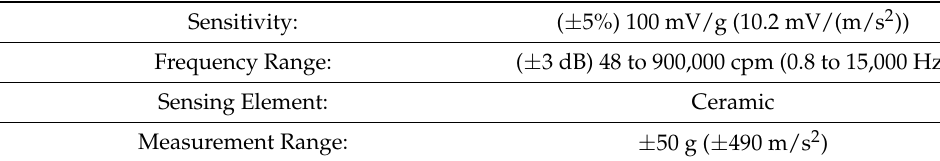
Figure 3. Schematic of the Self-Excited Acoustical System. Table 1. The Piezo-accelerometer IMI 623C01 specification.